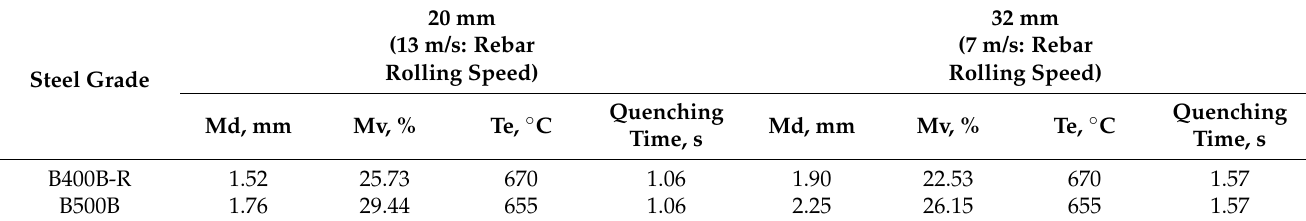
Table 3. The effect of different steel compositions on the formed tempered zone for rebars.